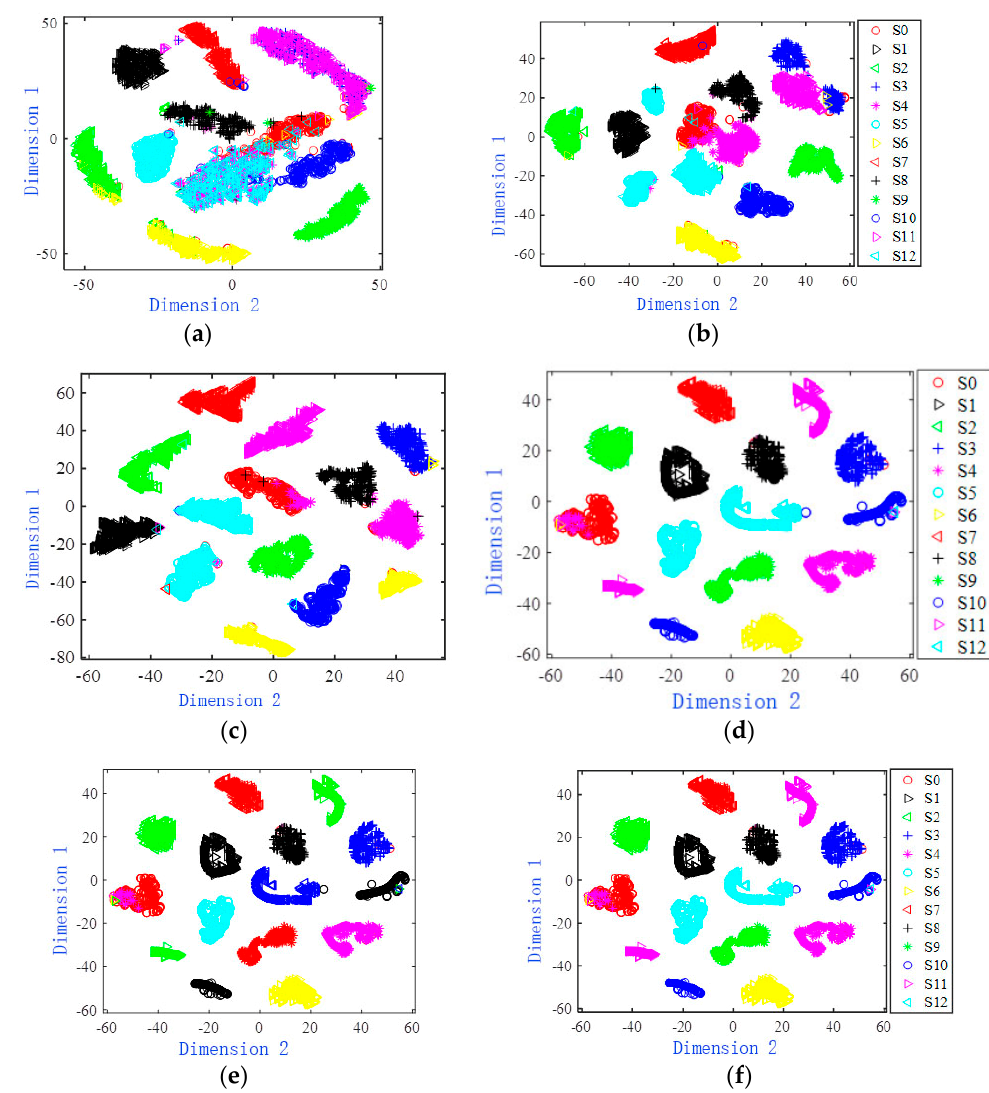
Figure 8. Two-dimensional scatter distribution of original data and features extracted from each network model in Four-opamp biquad high-pass filter circuit formed by T-SNE method. ( a ) Circuit fault data. ( b ) Features extracted by the BPNN network. ( c ) Features extracted by the RNN net- work. ( d ) Features extracted by the LSTM network. ( e ) Features extracted by the 1DCNN network. ( f ) Features extracted by the MSCNN-SK network.